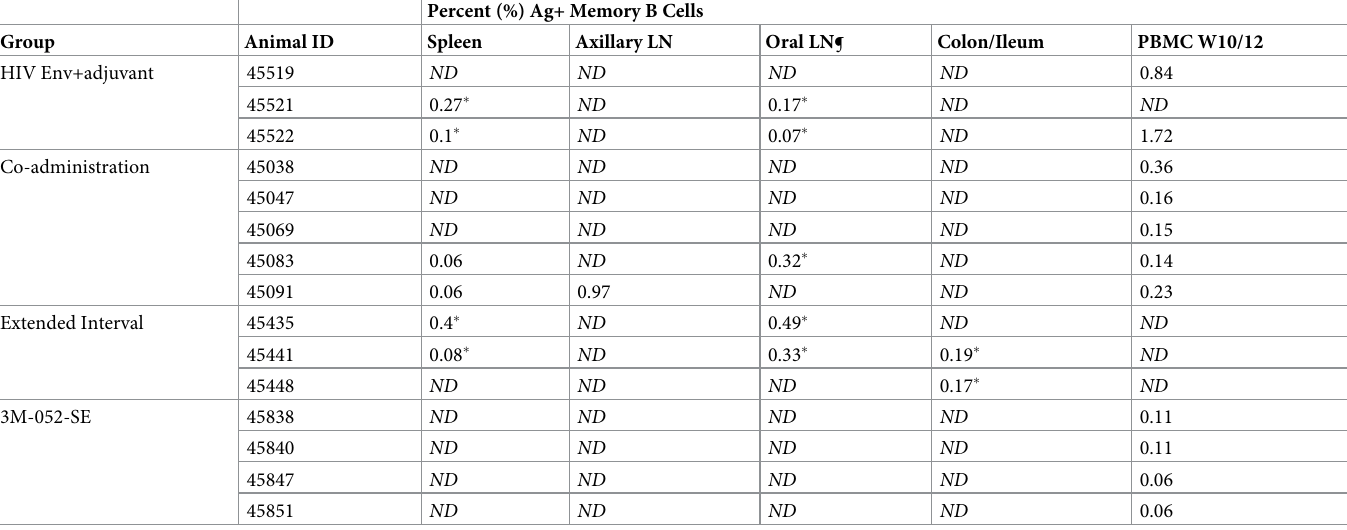
Table 1. Frequency of Env-specific memory B cells in sorted tissues and PBMCs of envelope-vaccinated infant